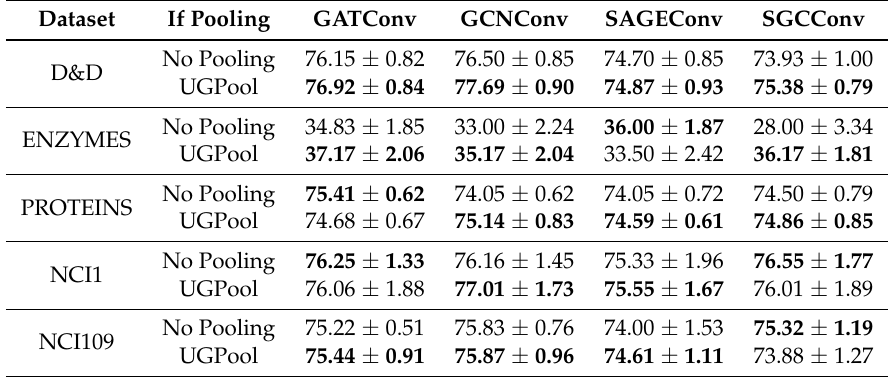
Table 4. Classification accuracy on benchmark datasets with and without global UGPool